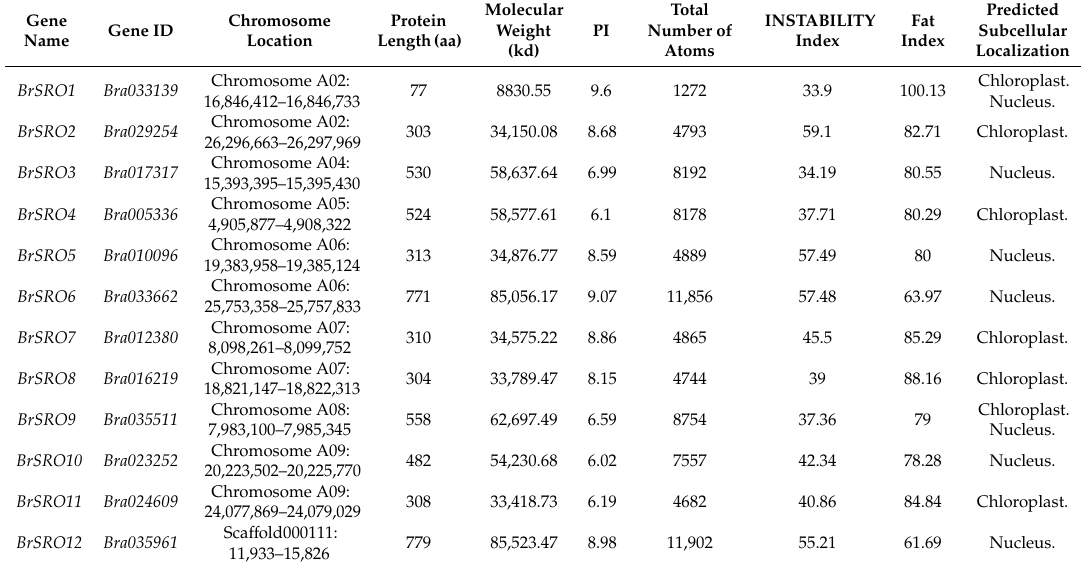
Table 1. Physiochemical characteristics of identified BrSRO genes.